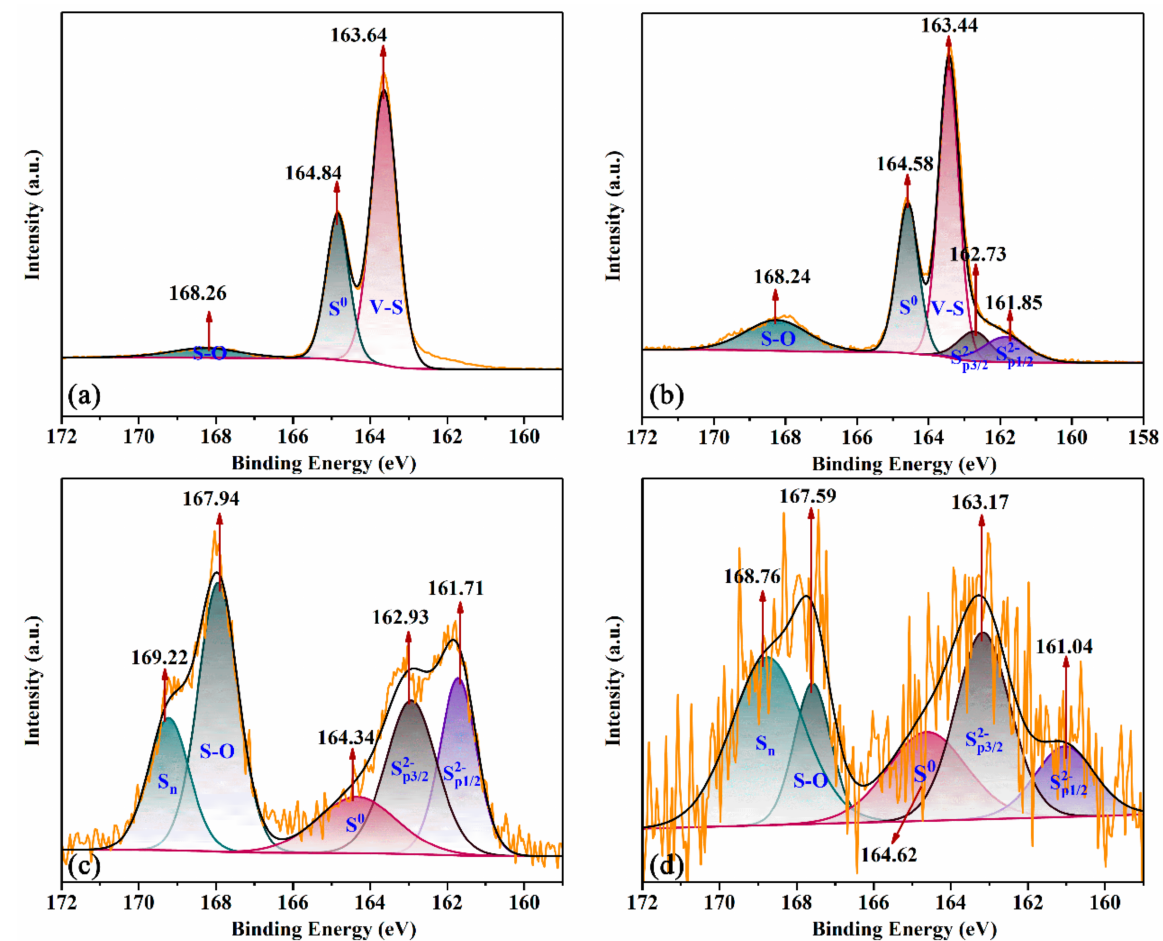
Figure 4. The XPS spectra from optimum total alkalinity at ( a ) 1 h; ( b ) 4 h; ( c ) 7 h; ( d ) 8